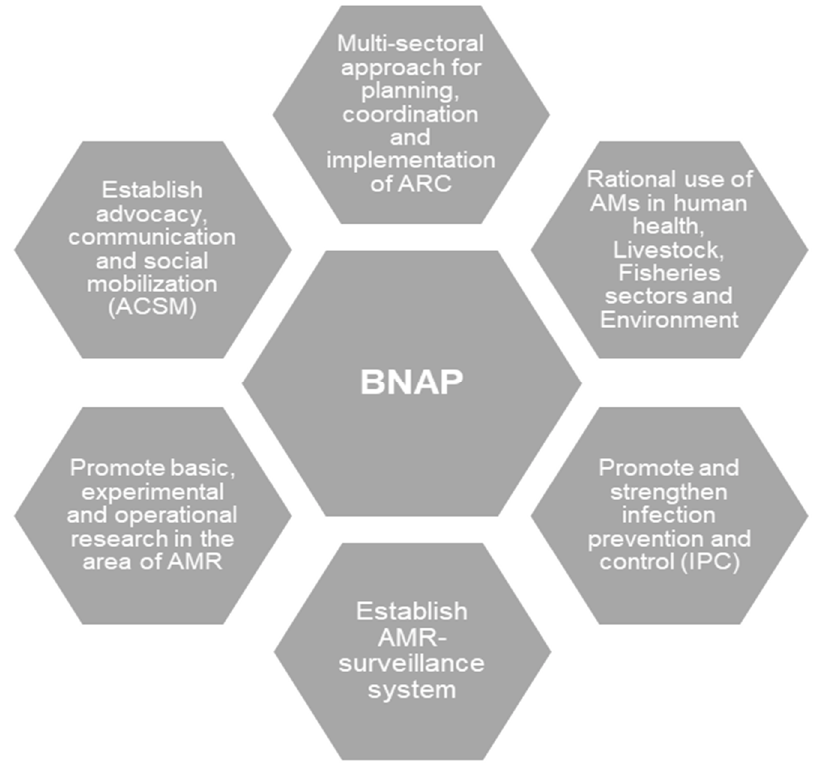
Figure 2. Bangladesh National Action Plan (BNAP): Antimicrobial Resistance Containment in Bangladesh 2017–2022 [21].